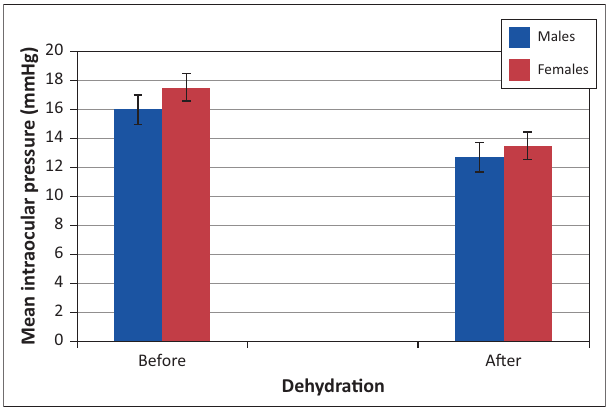
FIGURE 2: Mean intraocular pressure in men ( N = 27) and women ( N = 23) before and after dehydration. There was no statistically significant difference between mean IOP intraocular pressure in men and women both before and after dehydration ( p > 0.05).